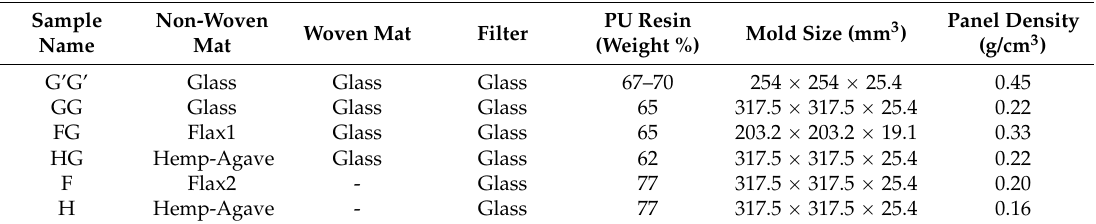
Table 2. Composition of the fiber reinforced composite material samples manufactured in the lab.